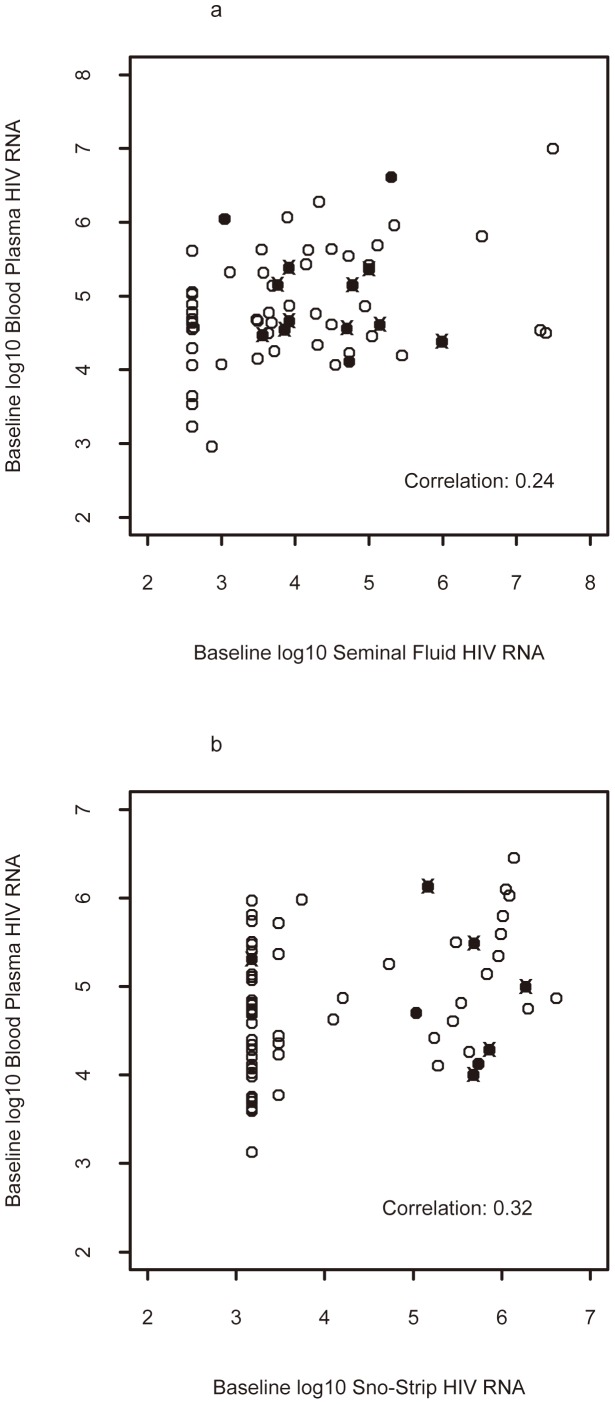
Association of Blood-Plasma and Genital Tract Fluid HIV RNA by Sex.Scatterplots demonstrating the Spearman correlations between blood and seminal plasma (A) and between blood and SnoStrip (B) viral load. Filled symbols represent those with paired blood and genital secretion genotypes; individuals with detectable drug resistance mutations in either blood or genital secretions are marked with an ‘x’.